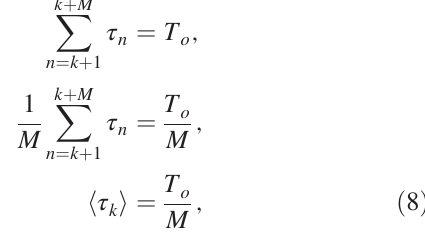
FIG. 1. A hypothetical ring with eight BPMs at longitudinal positions which are marked with red circles. When the mixed BPM method is employed, a sampling error δ to the deviation of the BPM positions from hypothetical locations that divide the circumference of the ring in exactly eight equal parts, marked with blue circles. BPM 1 is set as the reference